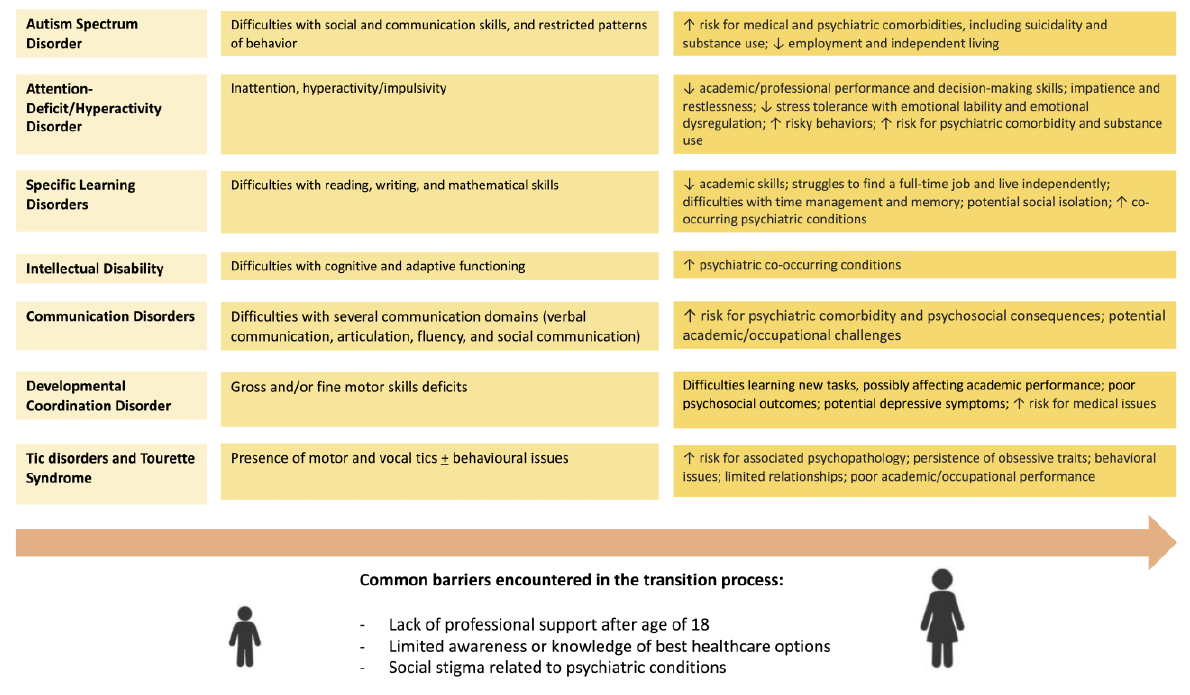
Figure 1. Graphical summary of the main clinical features and challenges encountered during adulthood for neurodevelopmental disorders.